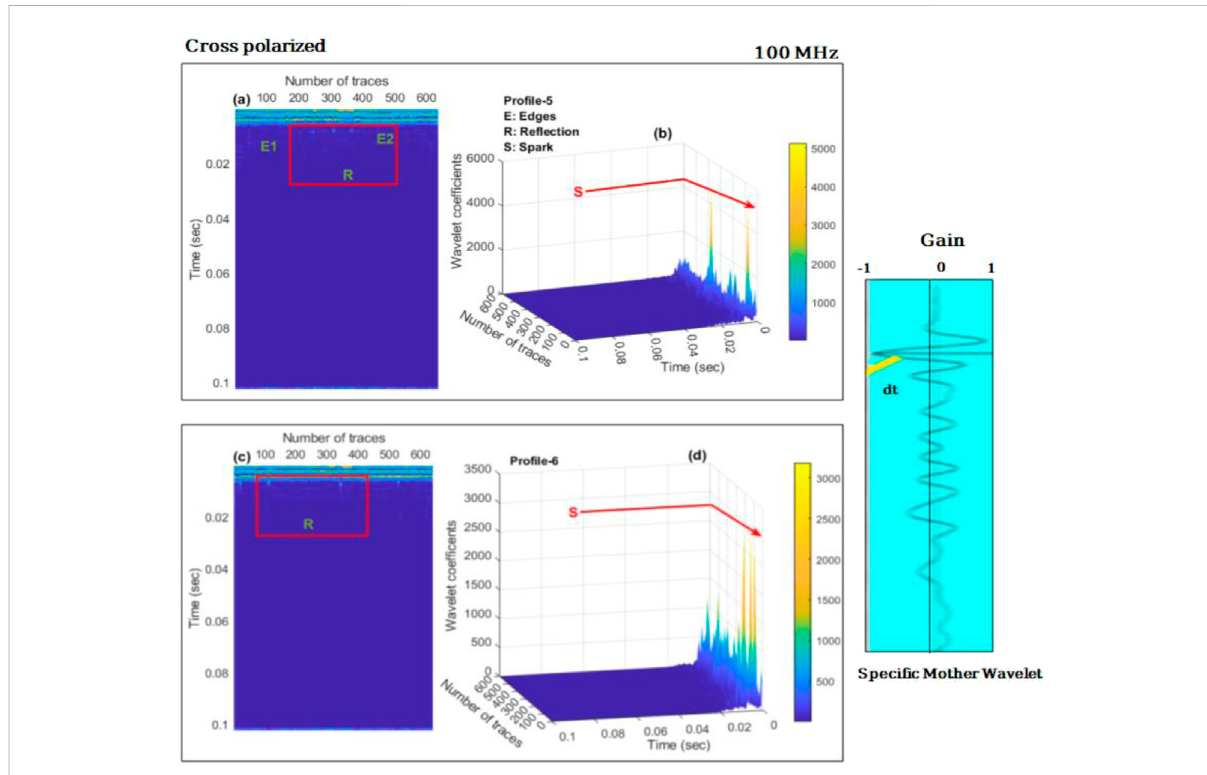
FIGURE 7 Continuouswavelettransformation(CWT)representationwithcross-polarizedGPRdataacquiredat100 MHzfrequency,where (A) 2-Ddisplay of post-applied CWT E1 and E2 are the representation of the archeological edges, while rectangular R is the re fl ection event that surfaced as a result of anomaly detection; and (B) post-application of Wavelet transform to the 3-D GPR data S de fi nes the spark at the time mode, and these sparks are connectedto theburiedsubsurfaceobjects. (C) Arectangular Rrepresents there fl ectionevent thathappenedas aresult ofanomalydetection. (D) When CWT is applied to 3-D GPR data, the spark in time mode is represented by S; these sparks are connected to bury subsurface objects. A chosen mother wavelet is also shown in the fi gure.